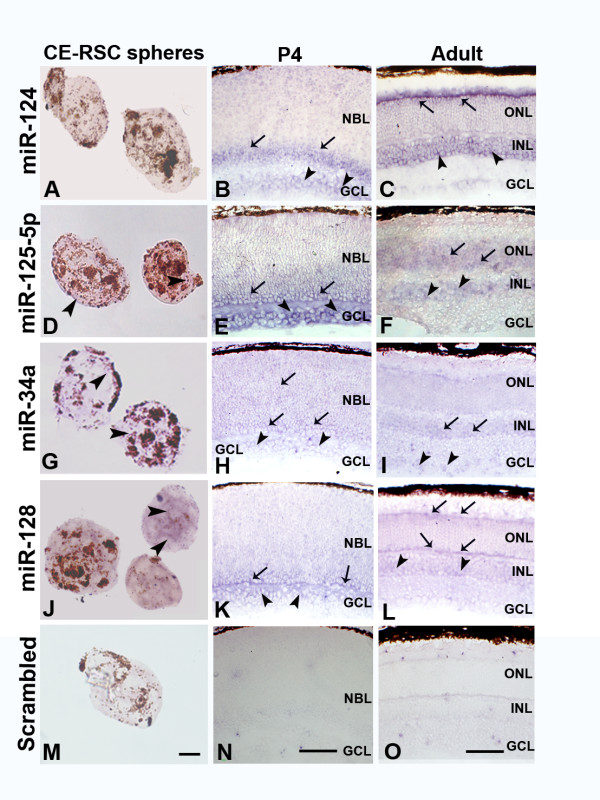
Cellular expression of selected miRNAs. ISH was performed on porcine CE-RSC neurospheres, and P4 and adult mouse retinas. Some neurosphere cells are naturally pigmented (dark brown). A: No positive signal was detected for miR-124 in CE-RSC neurospheres. B: Expression of miR-124 at P4 corresponded to the location of amacrine (arrows) and ganglion cells (arrowheads). C: In the adult retina, miR-124 was expressed in all layers with the highest intensity in the photoreceptor inner segments (arrows) and cells in the INL (arrowheads). D: miR-125b-5p was detected in the RSC neurospheres (purple staining depicted with arrowheads). E: In the P4 retina strong expression of miR-125b-5p was found in the inner portion of the NBL (arrows) and GCL (arrowheads). F: In the adult retina expression of miR-125b was detected in the ONL (arrows) and INL (arrowheads). G: Weak hybridisation signal for miR-34a was observed in CE-RSC neurosphere cells (arrowheads). H: P4 retina displayed week miR-34a signal throughout NBL (arrows) and ganglion (arrowheads) I: In the adult retina the strongest signal for miR-34a was observed in the INL (arrows) and in some cells in the GCL (arrowheads). J: Strong hybridisation signal was detected for miR-128 in the CE-RSC neurospheres (arrowheads). K: In the P4 retina a hybridisation signal for miR-128 was observed in the inner portion of the NBL (arrows) and in some cells of the GCL (arrowheads). L: In the adult retina strongest miR-128 hybridisation signal was detected in the INL (arrowheads), the outer portion of the outer plexiform layer and photoreceptor inner segments (arrows). ISH with scrambled negative control gave no signal in CE-RSCs (M), P4 (N), or adult mouse retina (O). NBL-neuroblast layer, GCL-ganglion cell layer, INL-inner nuclear layer, ONL-outer nuclear layer. Scale bars 50 μm.